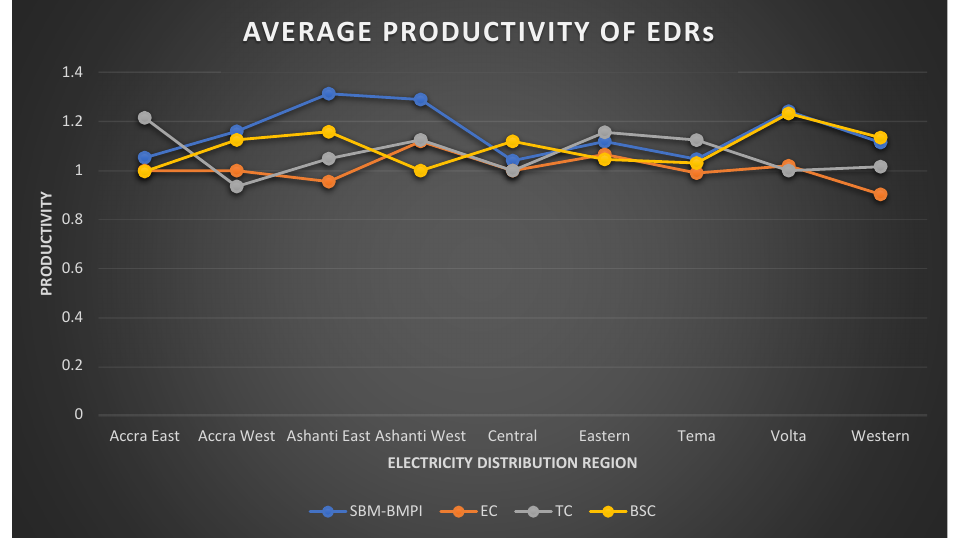
Figure 2. Average productivity of EDRs. Figure 2.